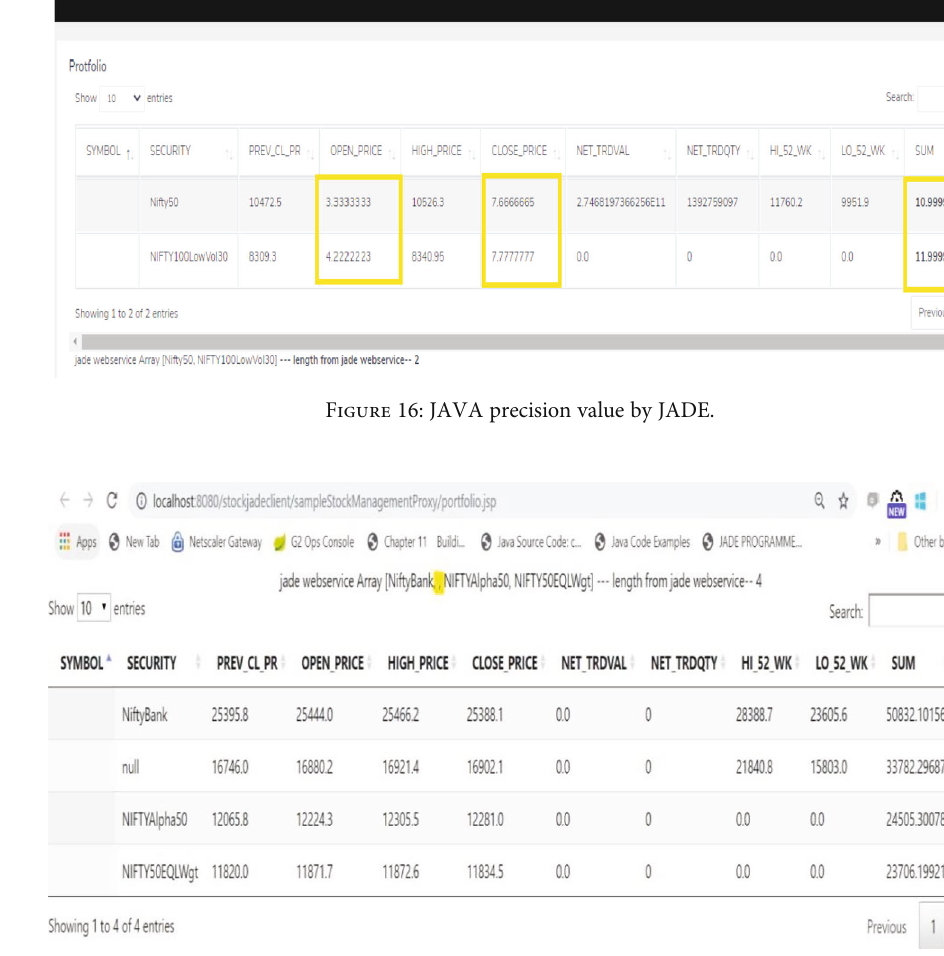
Figure 17: JADE result for null values.